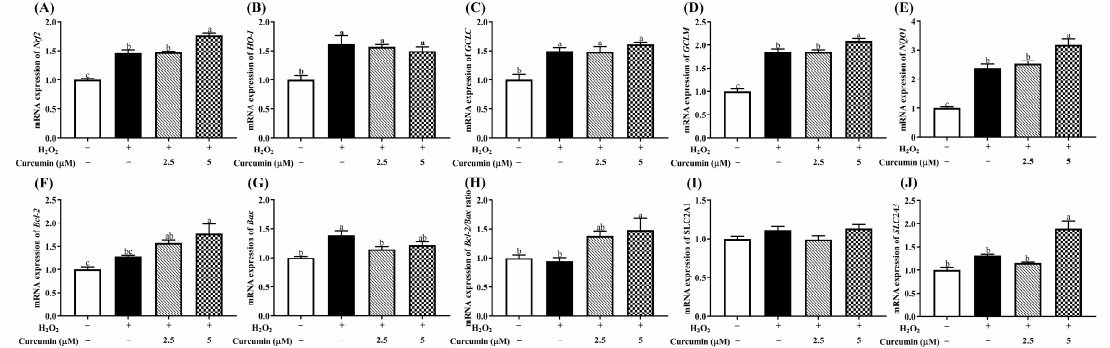
Figure 4. E ff ects of curcumin on the mRNA expression of Nrf2 ( A ) , HO-1 ( B ) , GCLC ( C ) , GCLM ( D ) , NQO1 ( E ) , Bcl-2 ( F ) , Bax ( G ) , Bcl-2 / Bax ratio ( H ) , SLC2A1 ( I ) and SLC2A3 ( J ) gene expression. Cells were pre-treated with 2.5 or 5 µ M curcumin for 24 h, and then treated with 400 µ M H 2 O 2 for another 24 h. GAPDH was used as a housekeeping gene. Data are presented as the mean ± SEM ( n = 3). a, b, c Means with di ff erent letters are significantly di ff erent ( p < 0.05). No letters or the same letters mean the no significantly difference.